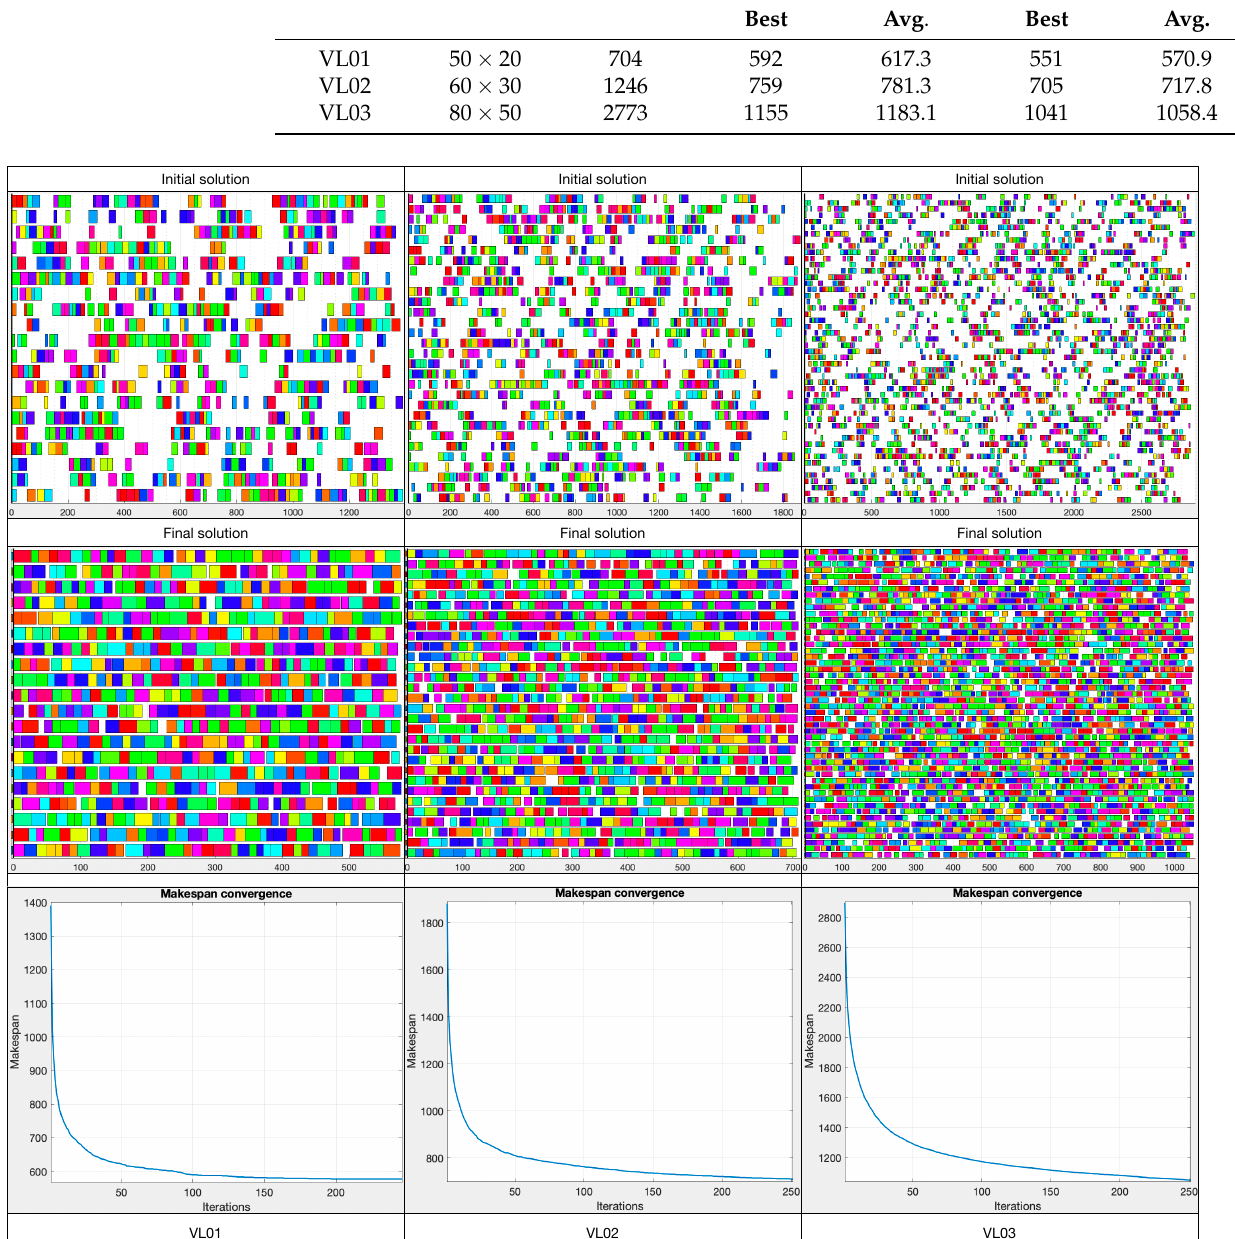
Figure 20. Comparison of the RPD difference per algorithm for the Vdata